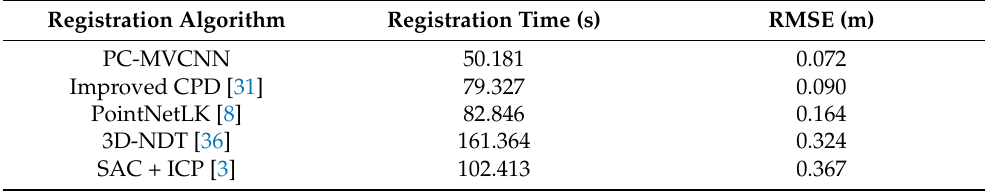
Figure 10. Local details of point cloud registration of Haikou Forest, Kunming City, Yunnan Province. ( a ) PC-MVCNN; ( b ) Improved CPD; ( c ) PointNetLK; ( d ) 3D-NDT; ( e ) SAC + ICP. Table 6. Registration results of various algorithms for Haikou Forest, Kunming City, Yunnan Province.